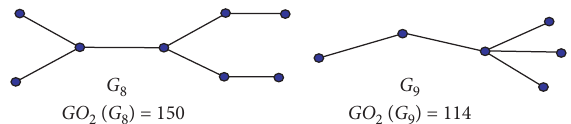
Figure 6: The graphs (a) G